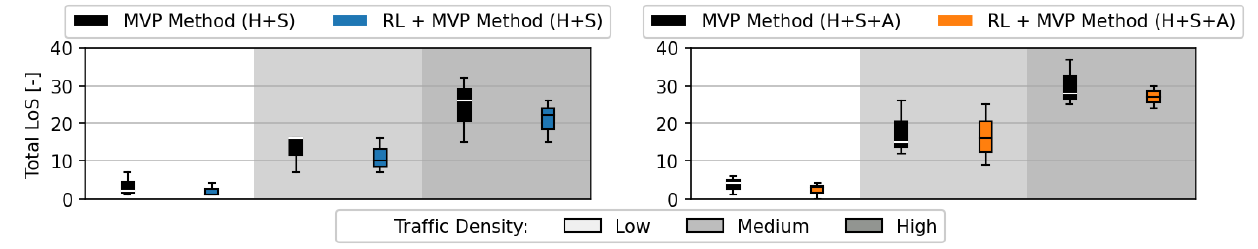
Figure 14. Total number of LoSs during testing of the RL agent.